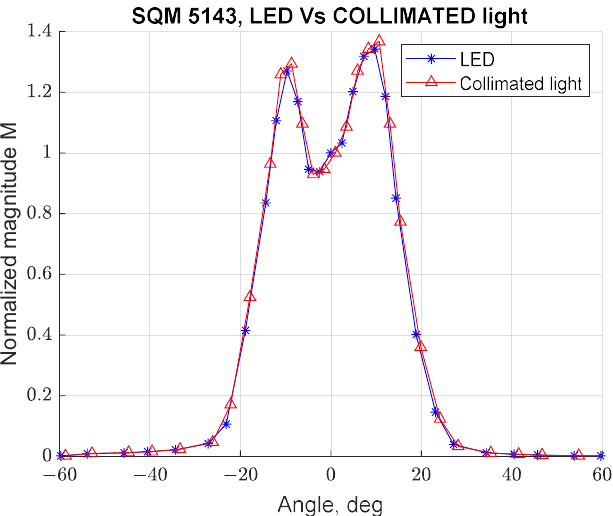
Figure 7. Comparison of normalized angular response curve for SQM-LE 5143 at different illumi- nation conditions: LED in blue, collimated light in red.